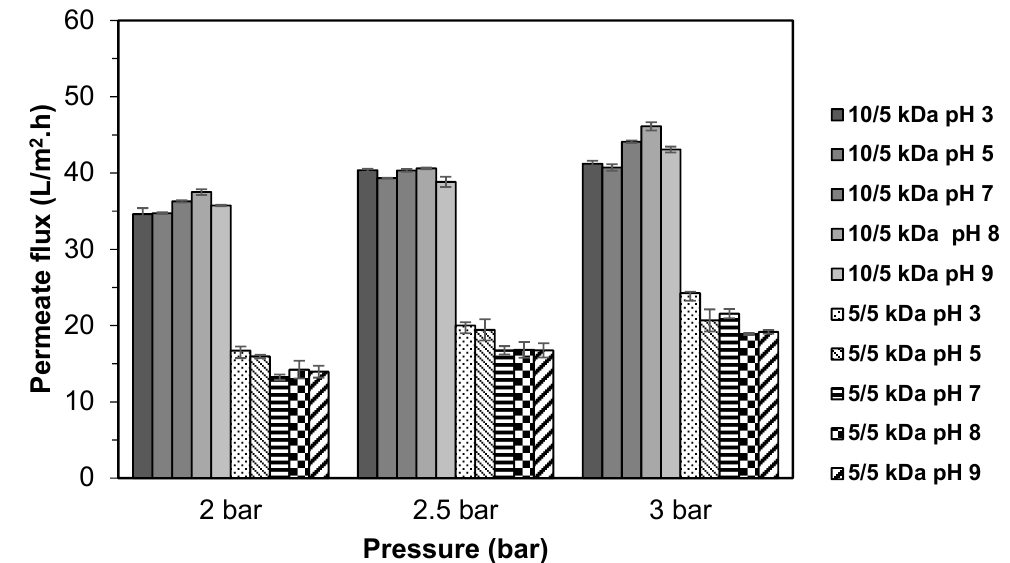
Figure 4. Permeate flux of TB protein hydrolysate using multilayer UF membranes at different pH of feed solutions.